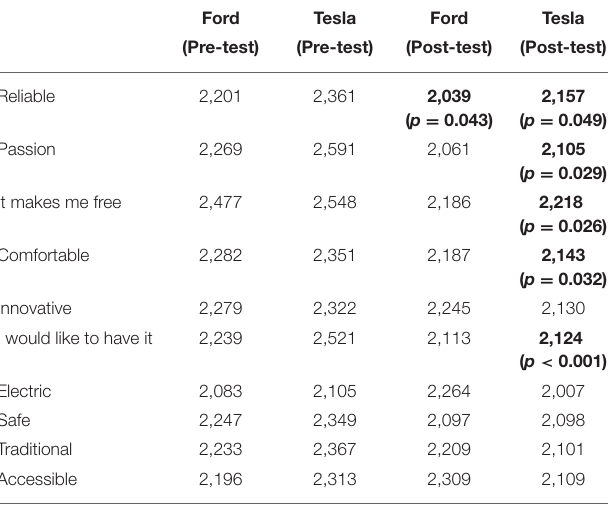
TABLE 5 | SoA expressed in milliseconds of the number of “yes” answers over TABLE 4 | Strength of Associations (SoA) expressed in milliseconds of the number the total sample (80 subjects exposed to the Tesla website). of “yes” answers over the total sample (80 subjects exposed to the Ford website). Ford Tesla Ford Tesla Ford Tesla Ford (Pre-test) (Pre-test) (Post-test)